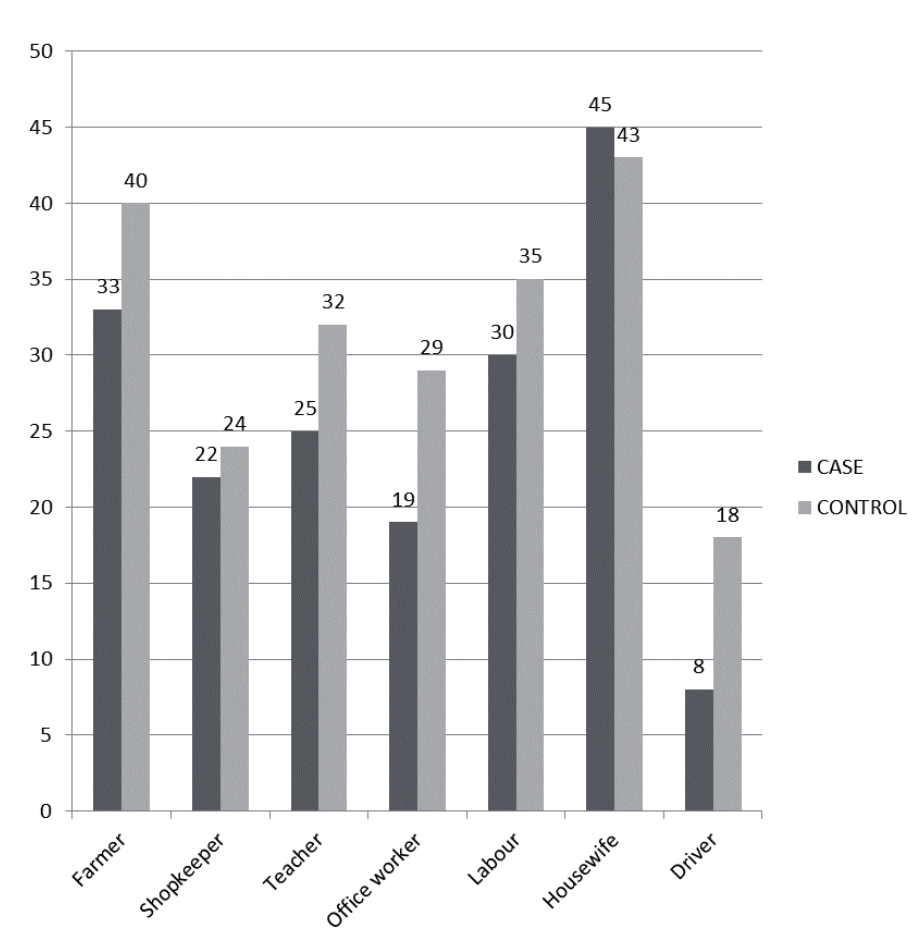
Figure 1. Occupation distribution between cases and controls (182 cases and 221 controls).